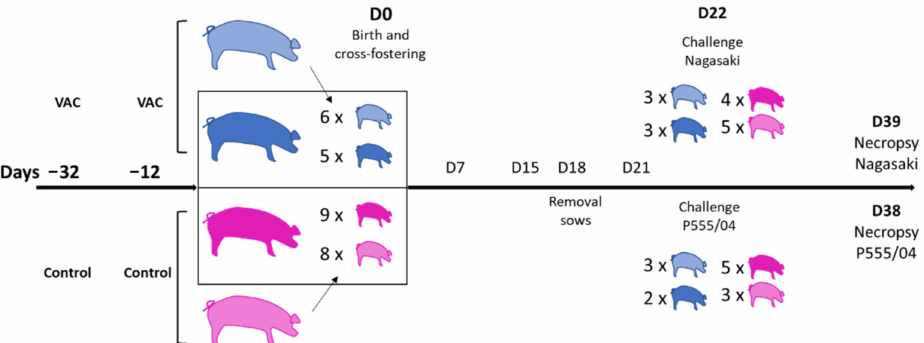
Figure 1. Schematic representation of the animal experiment. Two sows (in pale and dark blue) were vaccinated with VtaA fragment F4 at days − 32 and − 12 of farrowing, while two sows served as unvaccinated controls (in pale and dark pink). Al birth, D0, piglets (color indicates the sow of origin) were cross-fostered within each group and only one sow per group stayed in the study. Later, piglets were split in groups for inoculation at day 22 with two different serovars of G. parasuis : Nagasaki strain (SV5) represented in the upper part of the graph; and P555/04 (SV13) in the lower part. After 2 weeks, necropsies and final sampling were performed. Sampling points during the experiment were days 7, 15 and